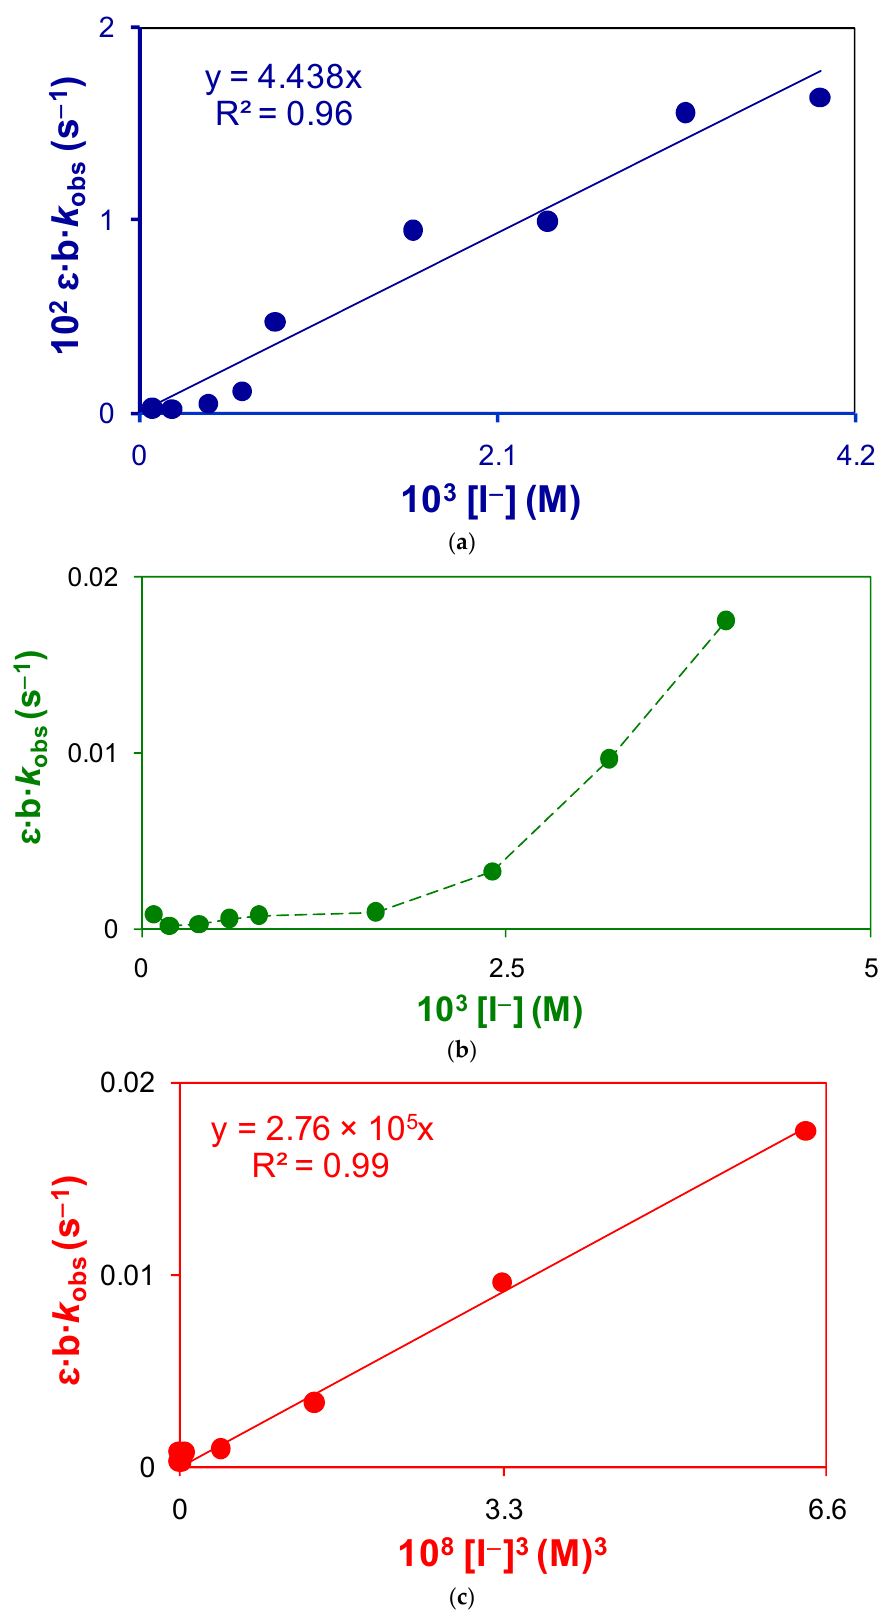
Figure 7. ( a ) Plot of first order with respect to iodide in 10% v / v dioxane–water at 293 ± 0.5 K. ( b ) Plot of first order with respect to iodide in 20% v / v dioxane–water at 284 ± 0.5 K. ( c ) Third-order plot with respect to iodide in 20% v / v dioxane–water at 284 ± 0.5